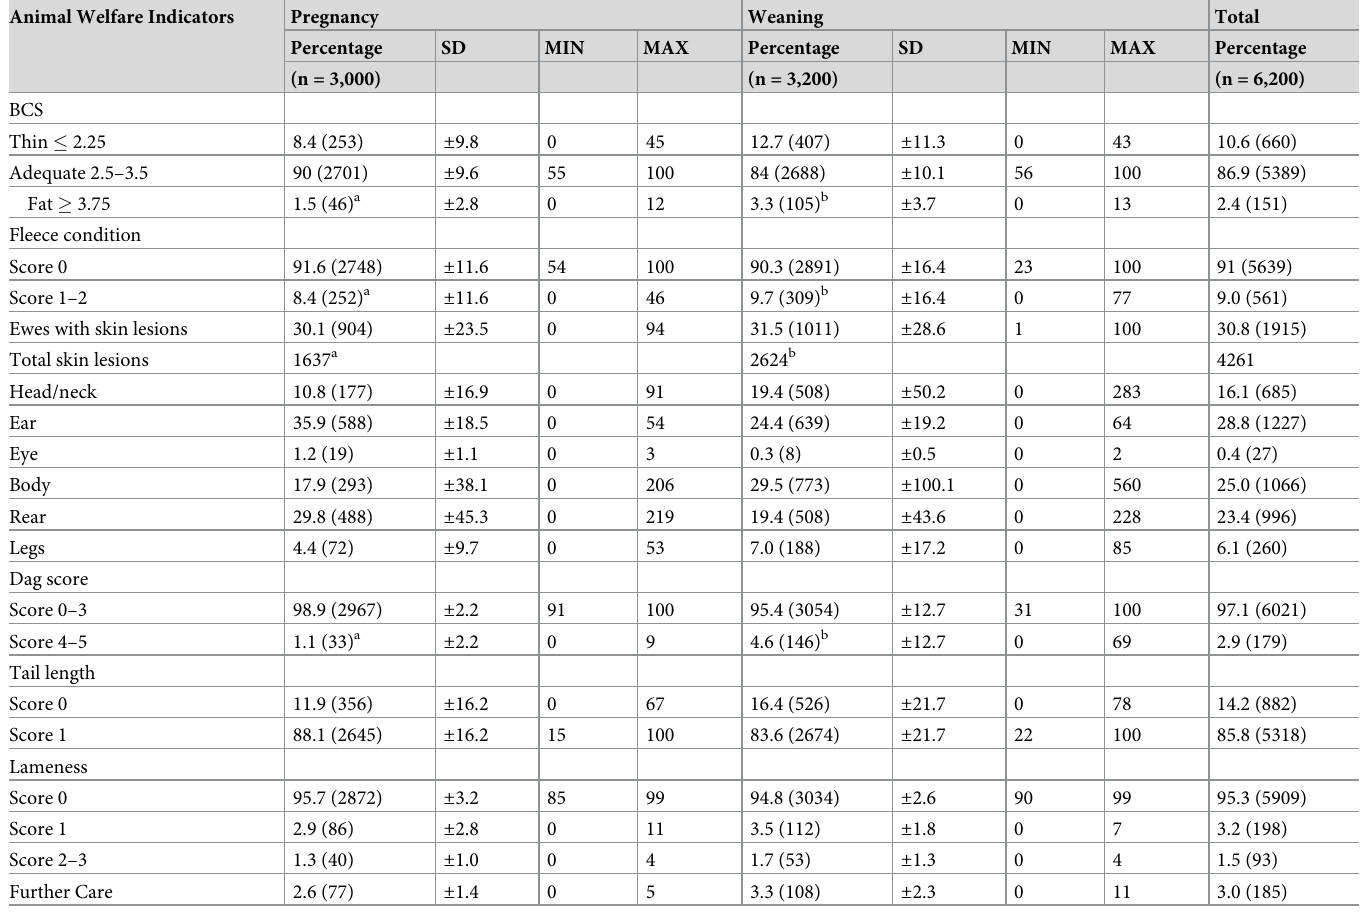
Table 3. Percentage, standard deviation (SD), minimum and maximum number scored in each category according to time of assessment; raw numbers presented in